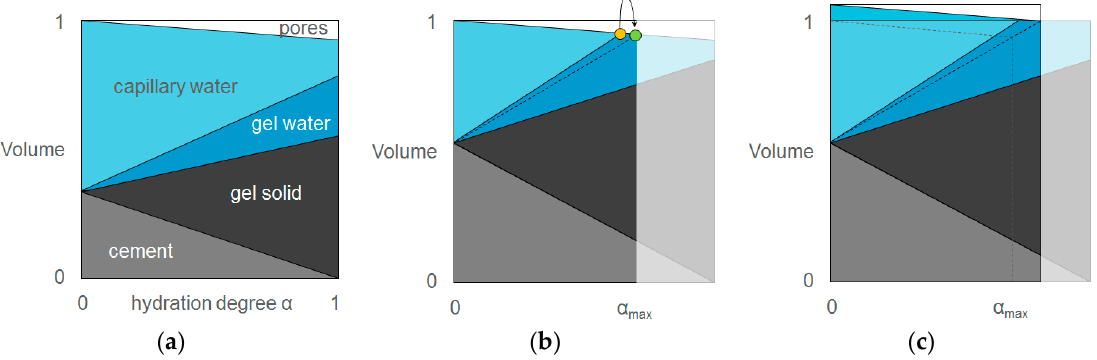
Figure 3. Principle of autogenous shrinkage in a system with a high water-to-cement ratio ( a ), and a low water-to-cement ratio without ( b ) and with internal curing ( c ).